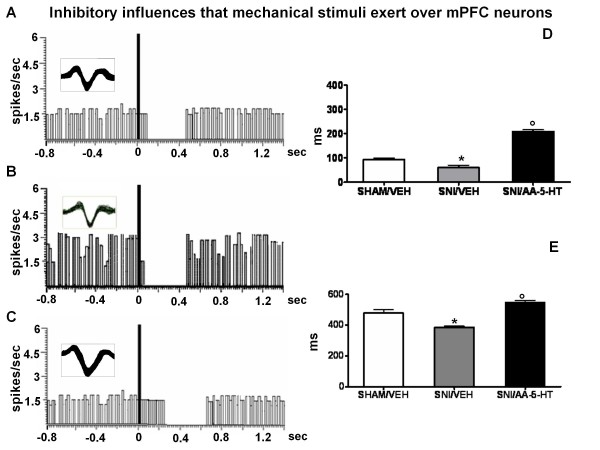
Mechanical nociceptive stimulation evokes inhibitory responses in the PL/IL cortex of BLA → PL/IL (-) neurons. The figure shows different parameters of mechanical nociceptive stimulation-evoked inhibition, including the onset and duration of the inhibition, in sham and SNI rats treated for 7 days with vehicle (veh) or AA-5-HT (5 mg/kg, i.p.). "A", "B" and "C" show a representative ratemater record of a mechanical stimulus → PL/IL (-) neurons of sham/veh, SNI/veh and SNI/AA-5-HT rat, respectively. "D" and "E" show the onset and duration (mean ± SEM) of the inhibition, respectively, in the different groups of rats. * indicates statistically significant difference versus sham/veh and º versus SNI/veh. P < 0.05 was considered as value of significance and n = 10 was used for each group.